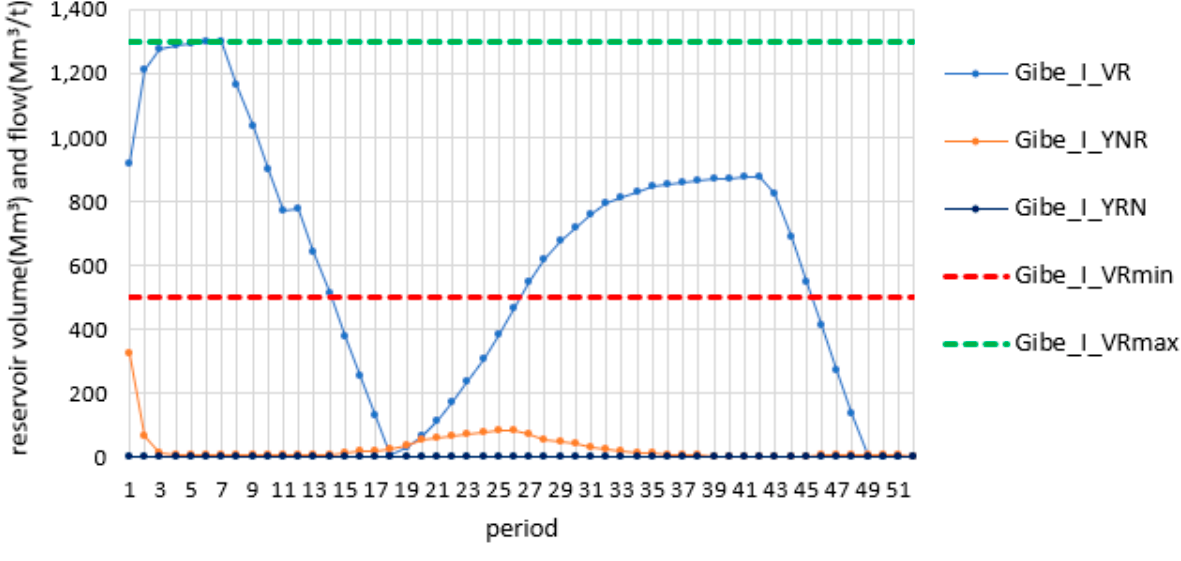
Figure 20. Gibe_I reservoir volume storage and reservoir inflow/outflow from and to river link (Mm 3 :Million cubic meters). (Mm 3 :Million cubic